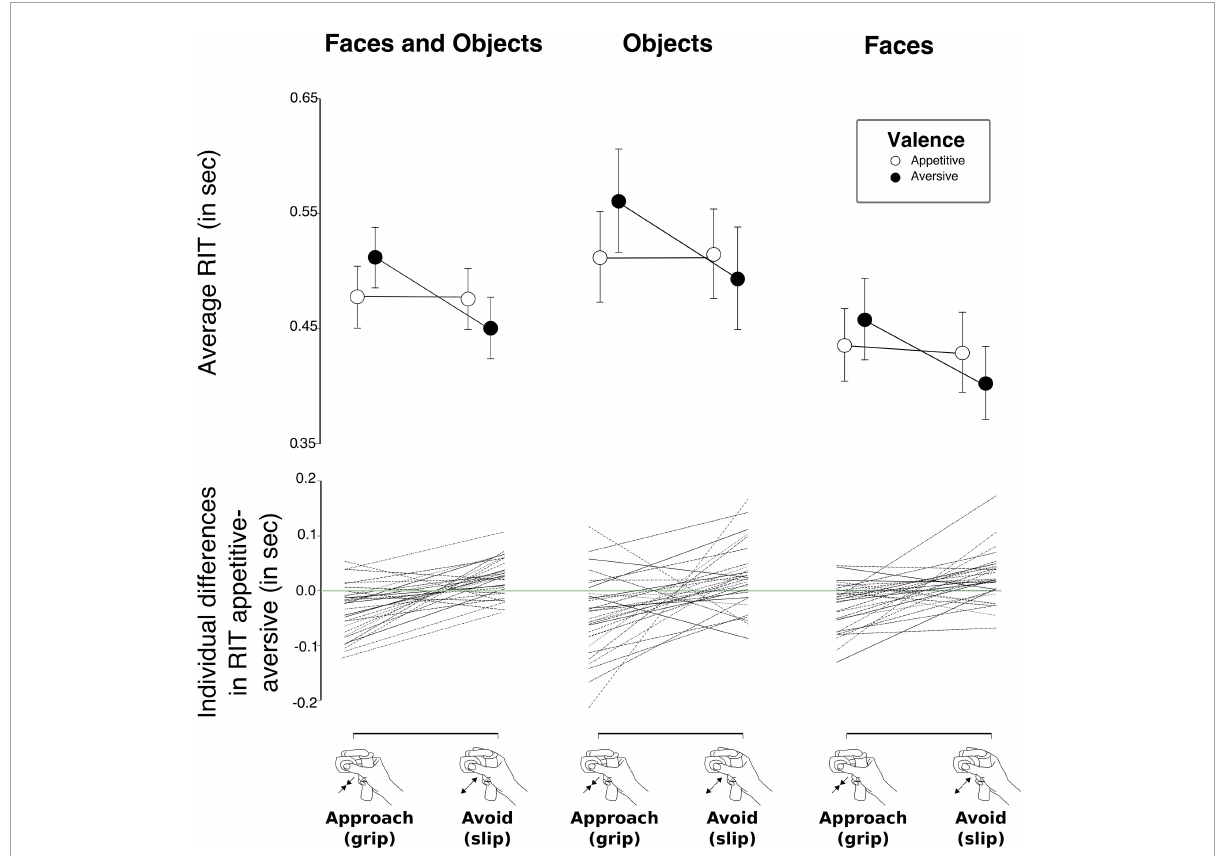
FIGURE4 (Upper row) Mean Response Initiation Times (RIT) for the two versions of our approach avoidance task (AAT) combined (left) as well as for the two versions of the AAT separately (middle and right). Across versions, participants were faster to initiate an “approach” response to appetitive stimuli and to initiate an “avoid” response to aversive stimuli than vice versa. Error bars denote 95% Bayesian credible interval. (Lower row) Individual deltas (RIT differences) for response initiation times in the approach appetitive–approach aversive conditions as well as for response initiation times in the avoid appetitive–avoid aversive conditions. Dotted lines connect the two deltas for each